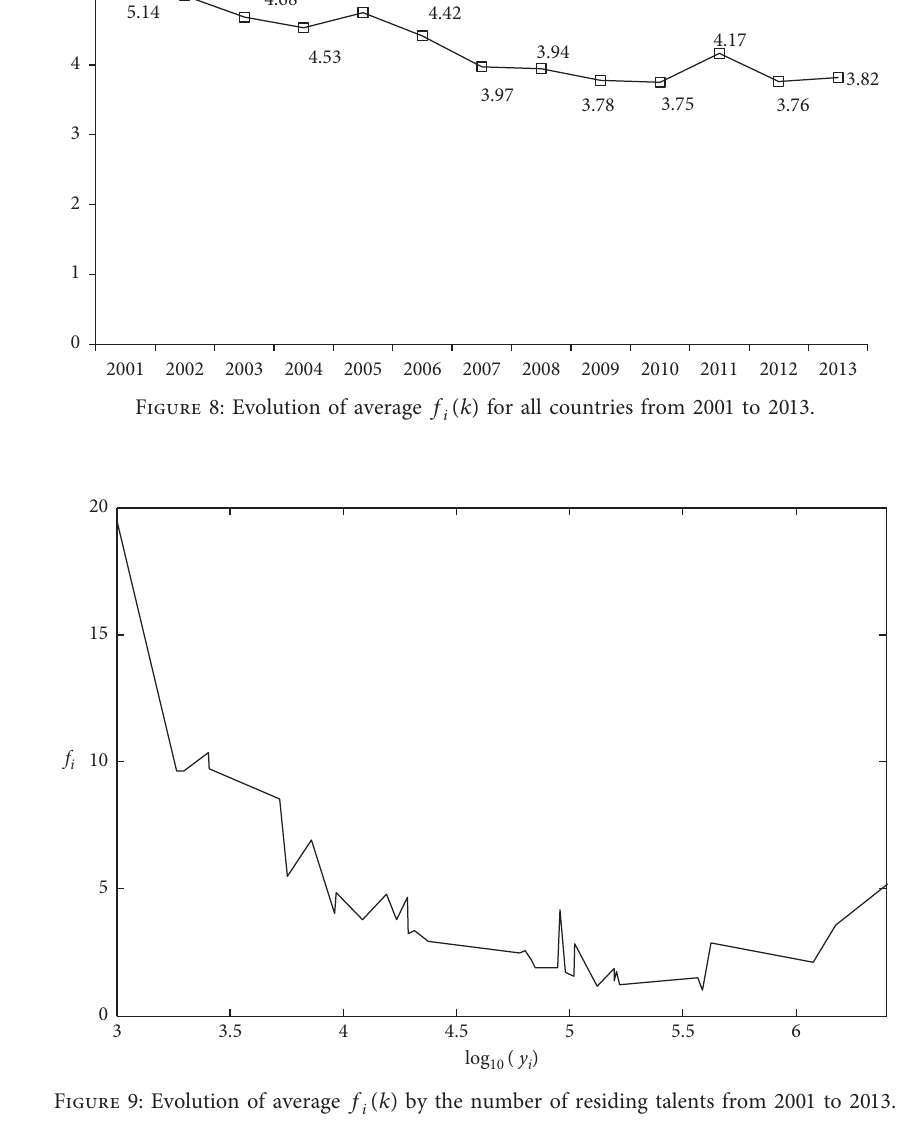
( k ) by the number of residing talents from 2001 to i